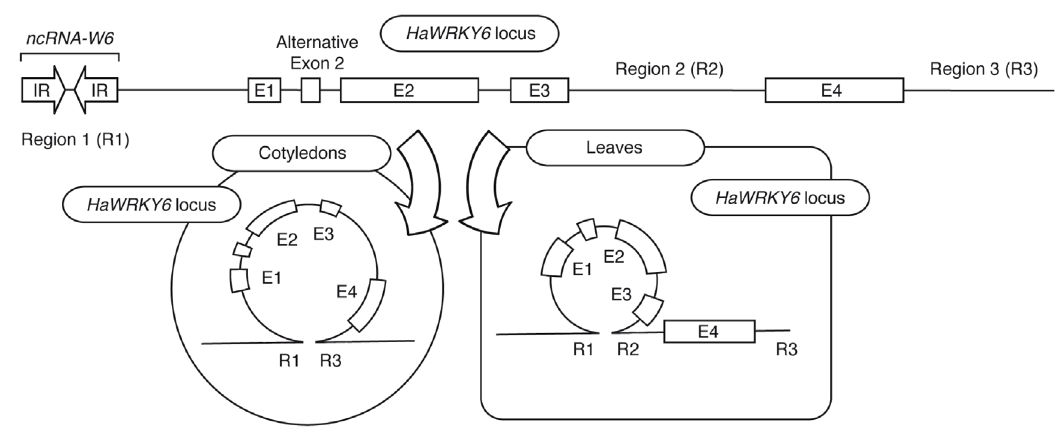
Figure 1. An inverted repeat (IR) transposable element regulates chromatin topology at the HaWRKY6 locus in sunflower. A simplified representation of the HaWRKY6 locus is shown, with opposed arrows indicating an IR transposable element and boxed segments indicating exons (E). Regions to which small RNAs (sRNAs) were mapped are indicated (regions R1–R3). The altered chromatin structure of the locus in cotyledons and leaves is diagrammatically presented. The chromatin loop encompasses the HaWRKY6 gene in cotyledons, enhancing transcription, while an intragenic loop forms in leaves, inhibiting transcription. The locus and exons are not drawn to